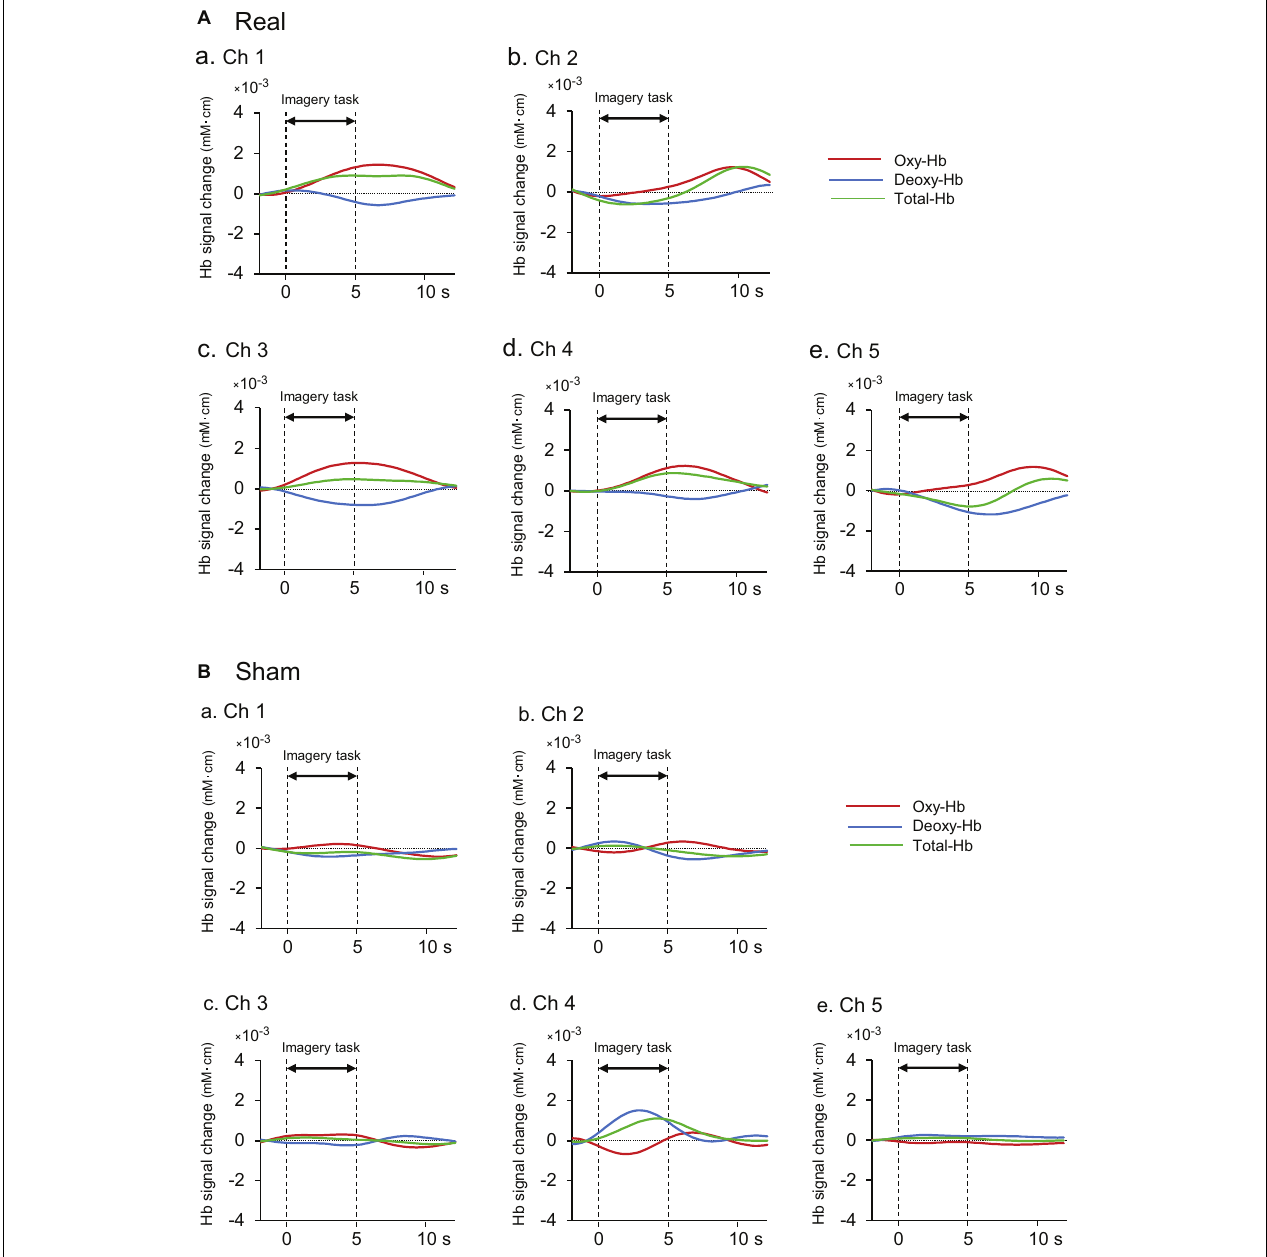
FIGURE 4 | Examples of hemodynamic responses in the feedback ROI (Ch 1-5) during motor imagery training in the real (Aa–Ae) and sham (Ba-Be) groups. (A) Hemodynamic responses in one subject of the real group. In Ch 1, 3, and 4, Oxy-Hb and Total-Hb concentrations increased after task onset, whereas Deoxy-Hb concentration gradually decreased during neurofeedback training. (B) Hemodynamic responses in one subject of the sham group. There were no apparent increases in Oxy-Hb concentration after the task